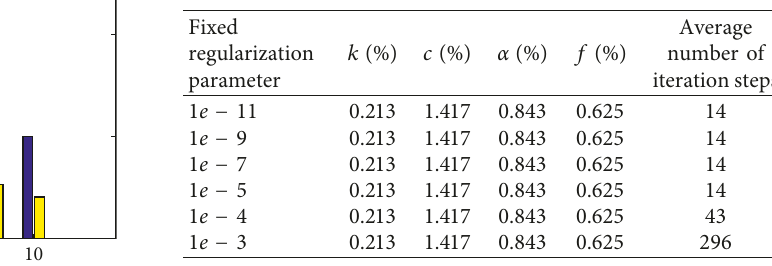
, (b) c , and (c) α and (d) a comparison of the identified load with the true load using a fixed 1 1 1 Table 2: Identified errors and average number of iteration steps with different fixed regularization